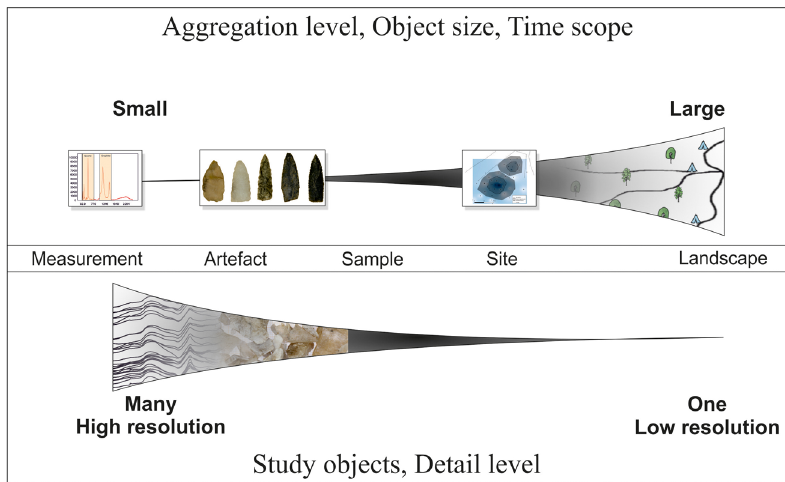
Figure 2: An illustration of the relationship between aggregation level and data resolution. With increasing aggregation level, such as in the reconstruction of past landscapes, the nuances of the underlying data become more vague ( i.e. lower resolution ) . Lower aggregation levels typically produce larger volumes of data with high detail, for instance in spectroscopy where a single artefact might have multiple measurements linked to